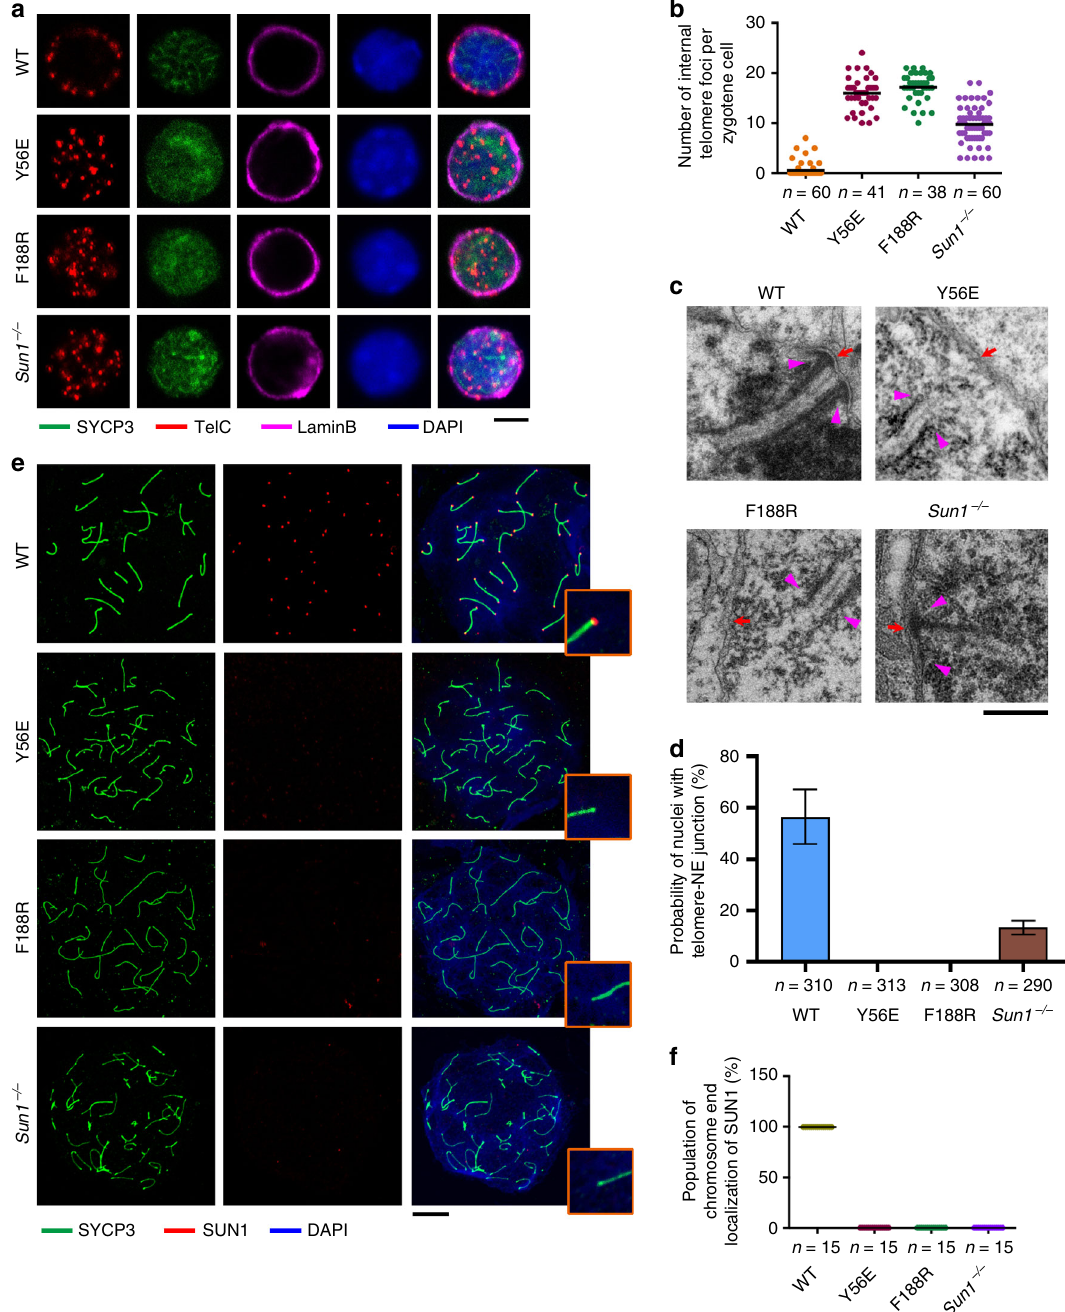
Fig. 8 Intact TERB1 – TERB2 – MAJIN complex is required for telomere – nuclear envelope (NE) attachment. a Equator images of structurally preserved zygotene spermatocytes from wild-type (WT), Terb2 Y56E , Terb2 F188R , and Sun1 − / − immunostained for SYCP3 and Lamin B and subjected to fl uorescence in situ hybridization of telomeric DNA probe (TelC). DNA was stained by 4,6-diamidino-2-phenylindole (DAPI). Scale bars, 5 μ m. b Quanti fi cation of internal telomere foci number shown in a . c Electron micrographs showing telomeres (magenta arrowheads) and nuclear membrane (red arrows) in WT pachytene and mutant pachytene-like spermatocytes. Scale bars, 500 nm. d Populations of nuclei from spermatocyte sections showing at least one telomere – NE attachment. Only nuclei with stretches of synaptonemal complex (SC) observed were counted for the quanti fi cation. Data are from three independent experiments with different mice and error bars indicate s.d. About 100 nuclei containing SC stretches from each mouse were counted for quanti fi cation. n is the total number of nuclei with SC stretches used for counting. e Chromosome spreads from adult spermatocytes were immunostained with anti-SYCP3 (green) and anti-SUN1 (red). DNA was stained by DAPI. The zoom-in views show one chromosome end from each spread. Scale bars, 10 μ m. f Dot blot showing population of chromosome ends with SUN1 foci in one nucleus. Source data are provided as a Source Data fi